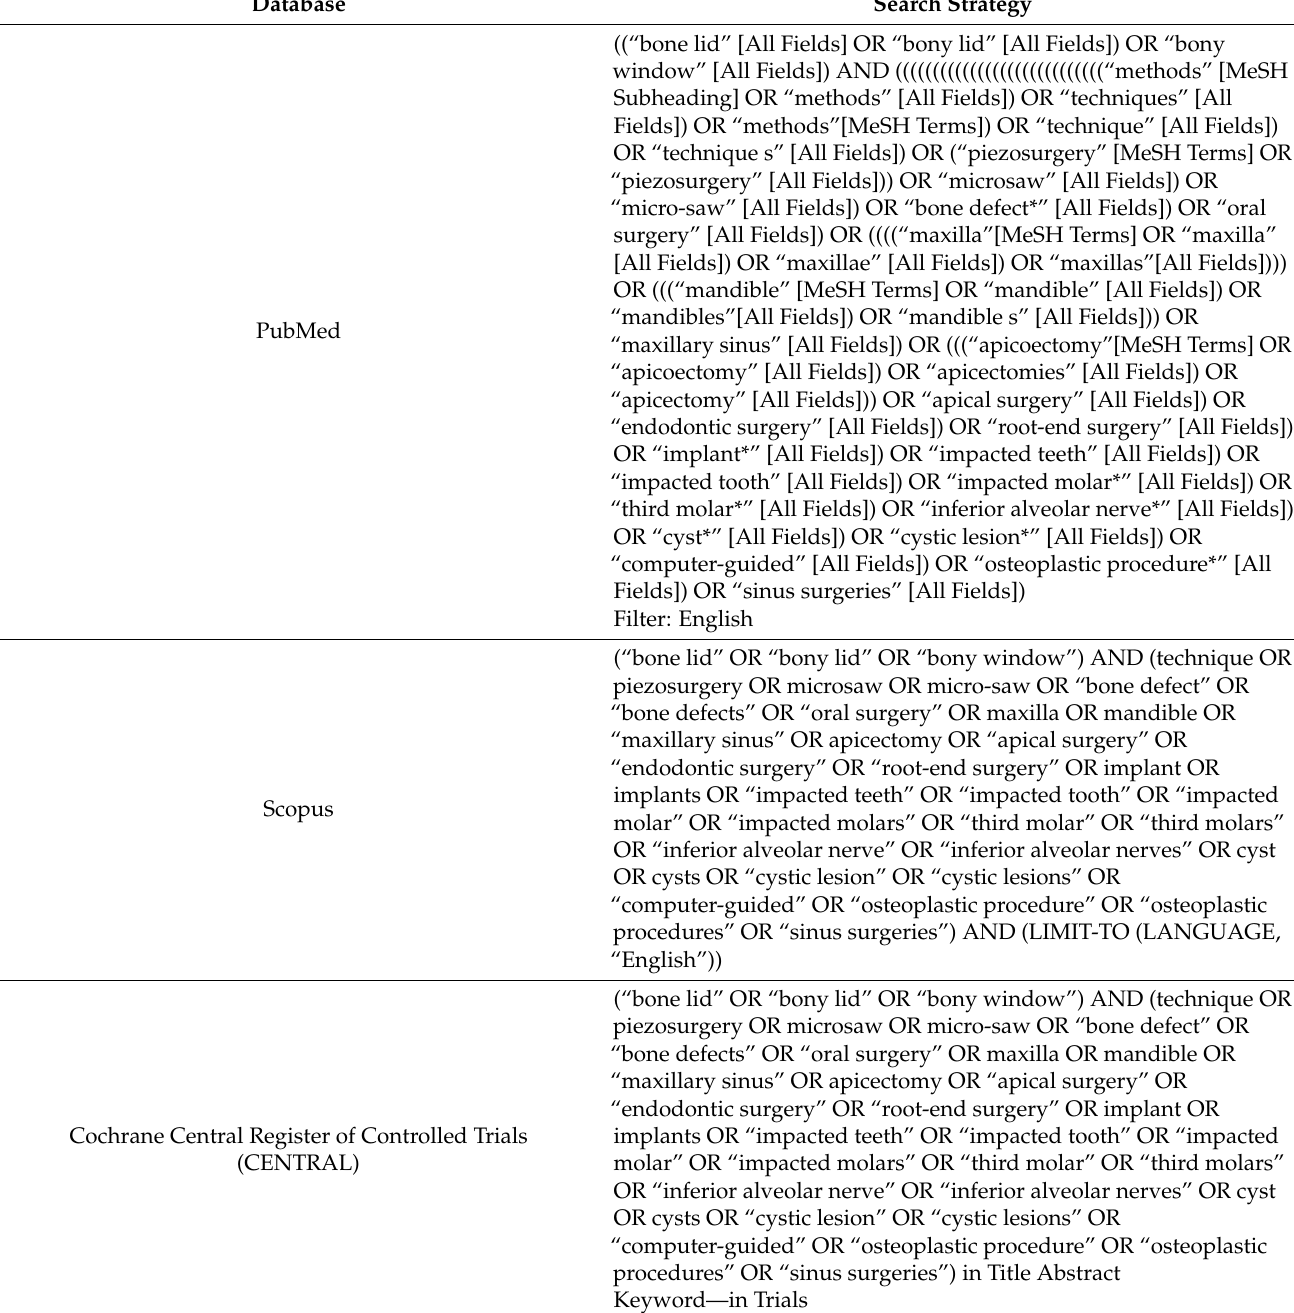
Table 1. Search strategies for the different